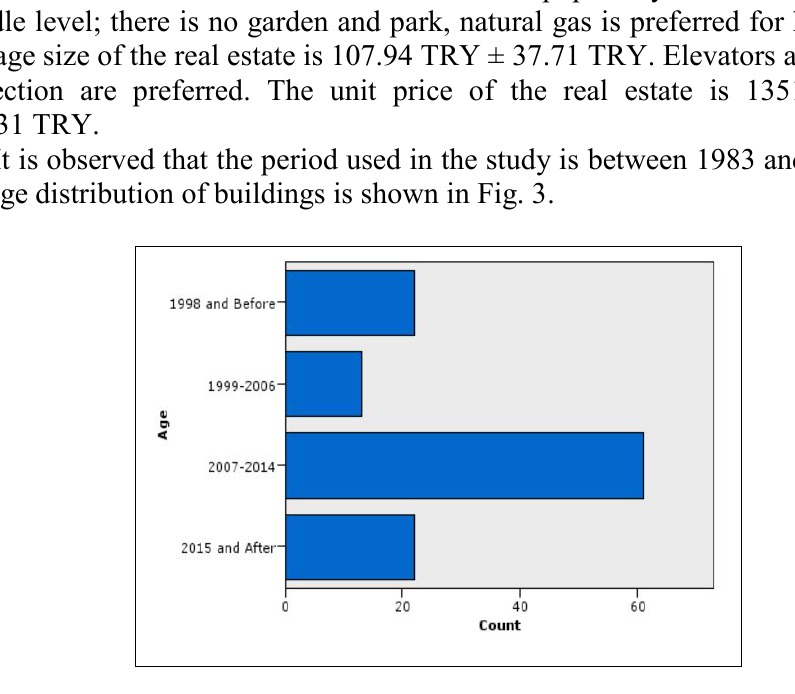
Fig. 3. Distribution of building age (developed by the authors).